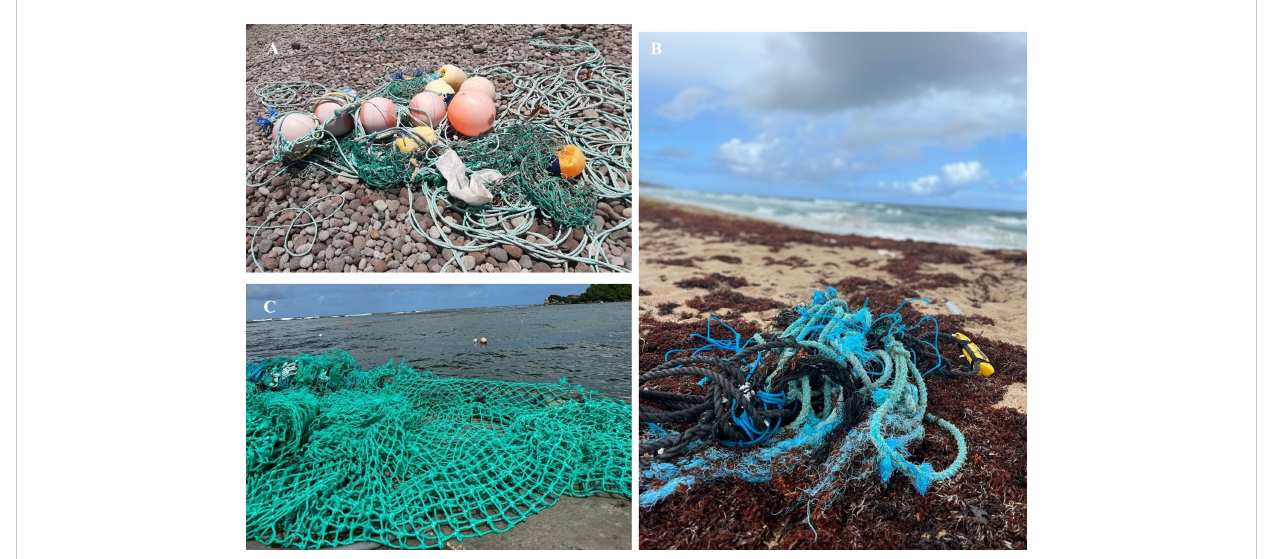
FIGURE 7 Examples of Gear Components that have been identi fi ed among derelict fi shing gear by Divers in the Eastern Caribbean (Clockwise): (A) Recovered FAD components, (B) Tangled Rope, (C) Polypropylene Netting.